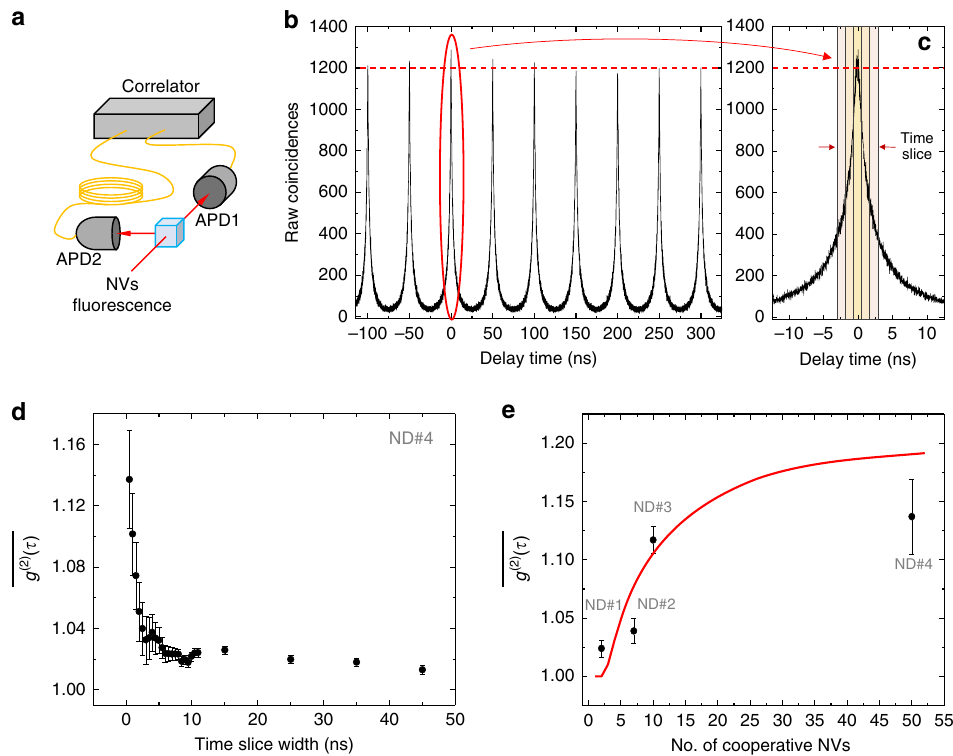
Fig. 3 Autocorrelation measurements. a Schematic representation of the Hanbury – Brown and Twiss interferometer. b Normalised coincidences for ND#4. c Time slicing employed to evaluate the autocorrelation function. d Measured time-integrated autocorrelation function g ð 2 Þ ð τ Þ , which approaches g (2) (0) as τ ! 0. For ND#4, g ð 2 Þ ð 0 Þ crests at 1.14 ± 0.02 for a time-slice width of 0.5 ns; it drops considerably as the width increases above 2 – 3 ns (after which the SR burst has exhausted) to then converge to Poissonian/random photoemission g ð 2 Þ ð τ Þ (cid:3) 1 expected from many NV centres at long times. Error bars are determined from the standard error of the area under the peaks, for each set of time slices, excluding the ‘ 0 ’ peak. e Measured maximum value of g ð 2 Þ ð 0 Þ for ND#1 – 4, and corresponding theoretically estimated number N max of NV centres acting cooperatively to produce such value of g ð 2 Þ ð 0 Þ using the initial state assumed by our model. Because of the fi nite time window for averaging (~ 0.5 ns) this is an underestimate of g (2) (0). The continuous line (red) sets the upper limit of our theoretical prediction for g (2)